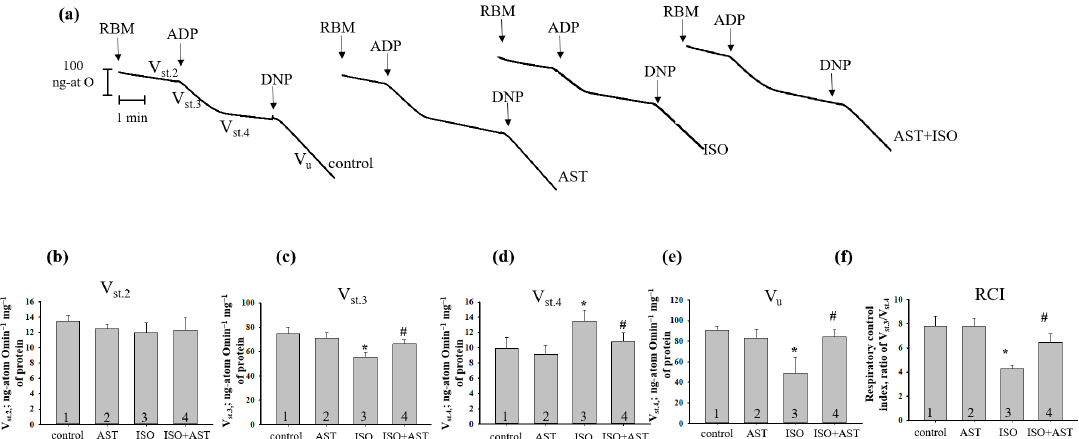
Figure 2. The effects of AST and ISO on respiratory activity in RBM. ( a ) Curves of respiratory activity. Arrows show the additions to RBM; ( b – f ) quantitative analysis of RBM respiration rate in states 2 (V st.2 ), 3 (V st.3 ), and 4 (V st.4 ). The concentration of ADP was 200 µM. DNF was 30 µM. Glutamate (5 mM) and malate (5 mM) were used as respiratory substrates. The data are presented as the means ± SDs of six independent experiments. * p < 0.05 significant values compared with control (group 1); # p < 0.05 significant values compared with RBM isolated from ISO-injected rats (group 3).